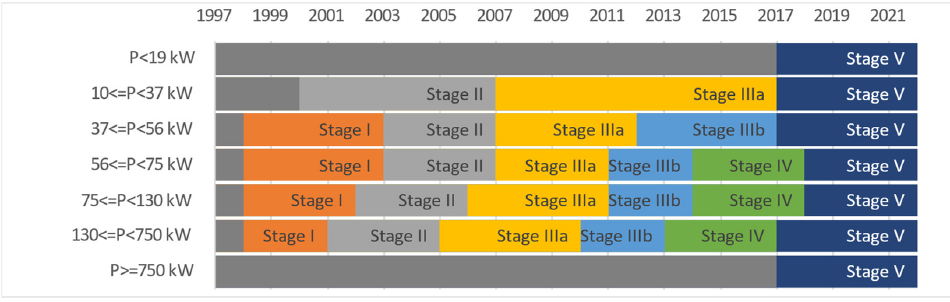
Figure 1. European off-road diesel engine emission regulations implementation by engine power.